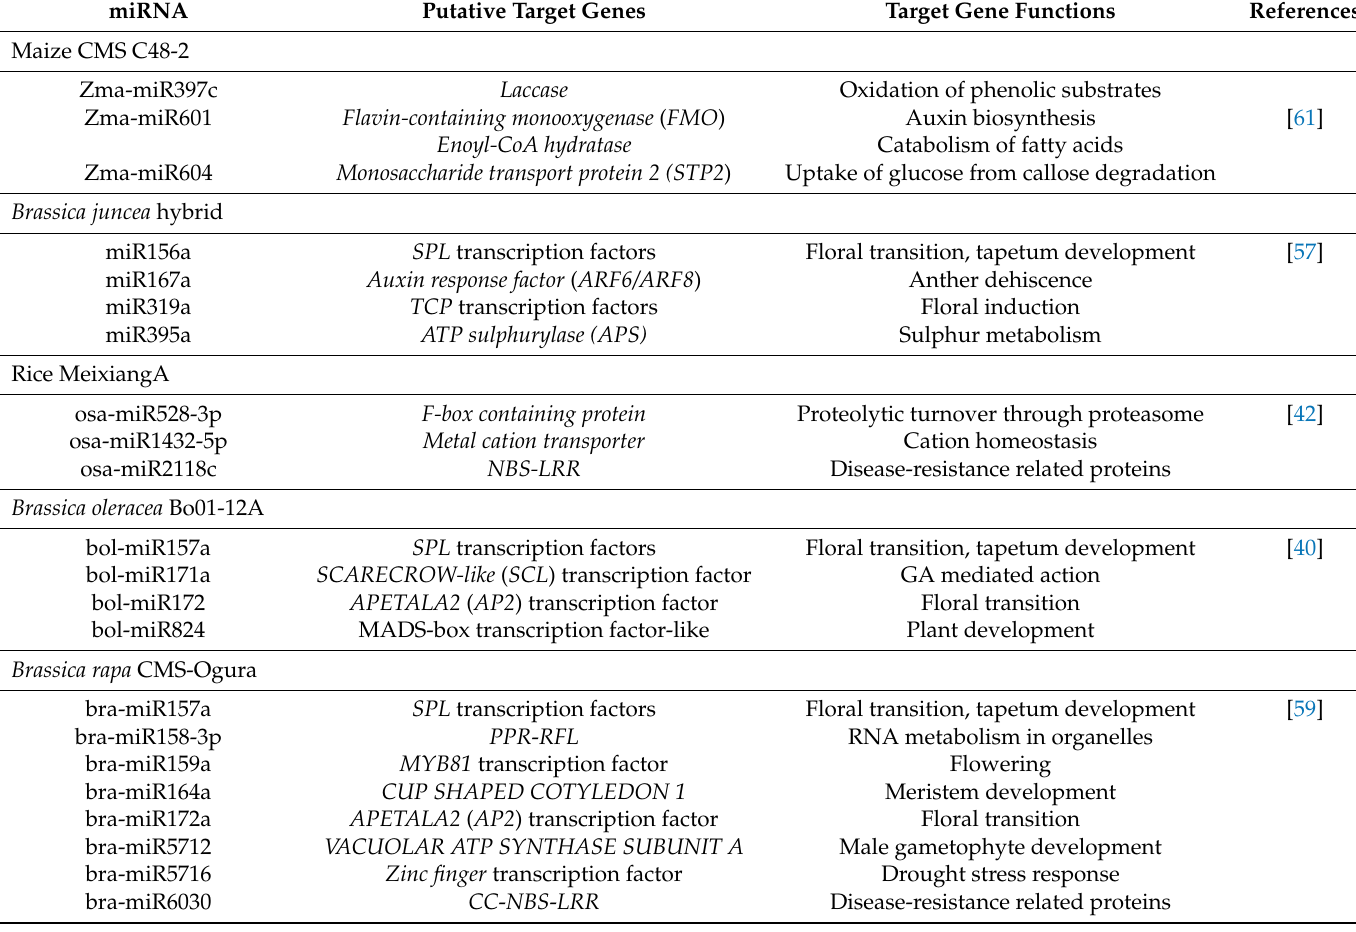
Table 1. The examples of miRNA and their putative target genes differentially expressed between the CMS lines and their maintainers in various